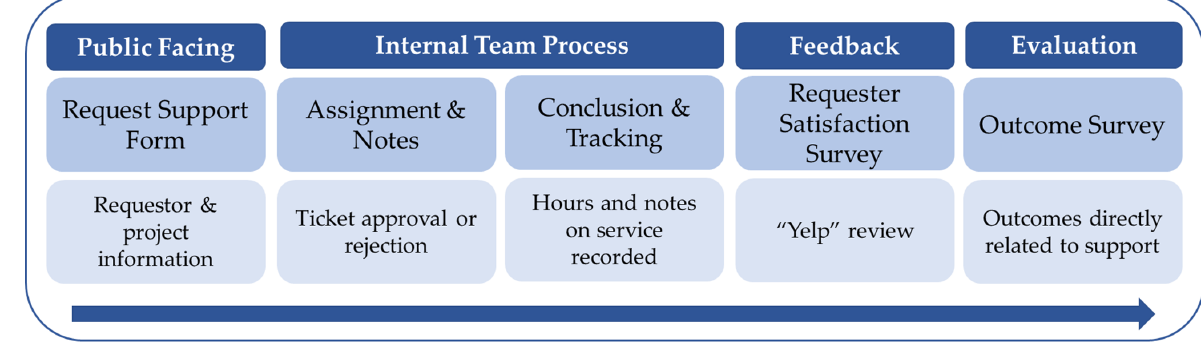
Figure 1. Time points in the REDCap project from the initial request to evaluation of outcomes. Table 1. Example of questions included in Phase I of the REDCap ticketing